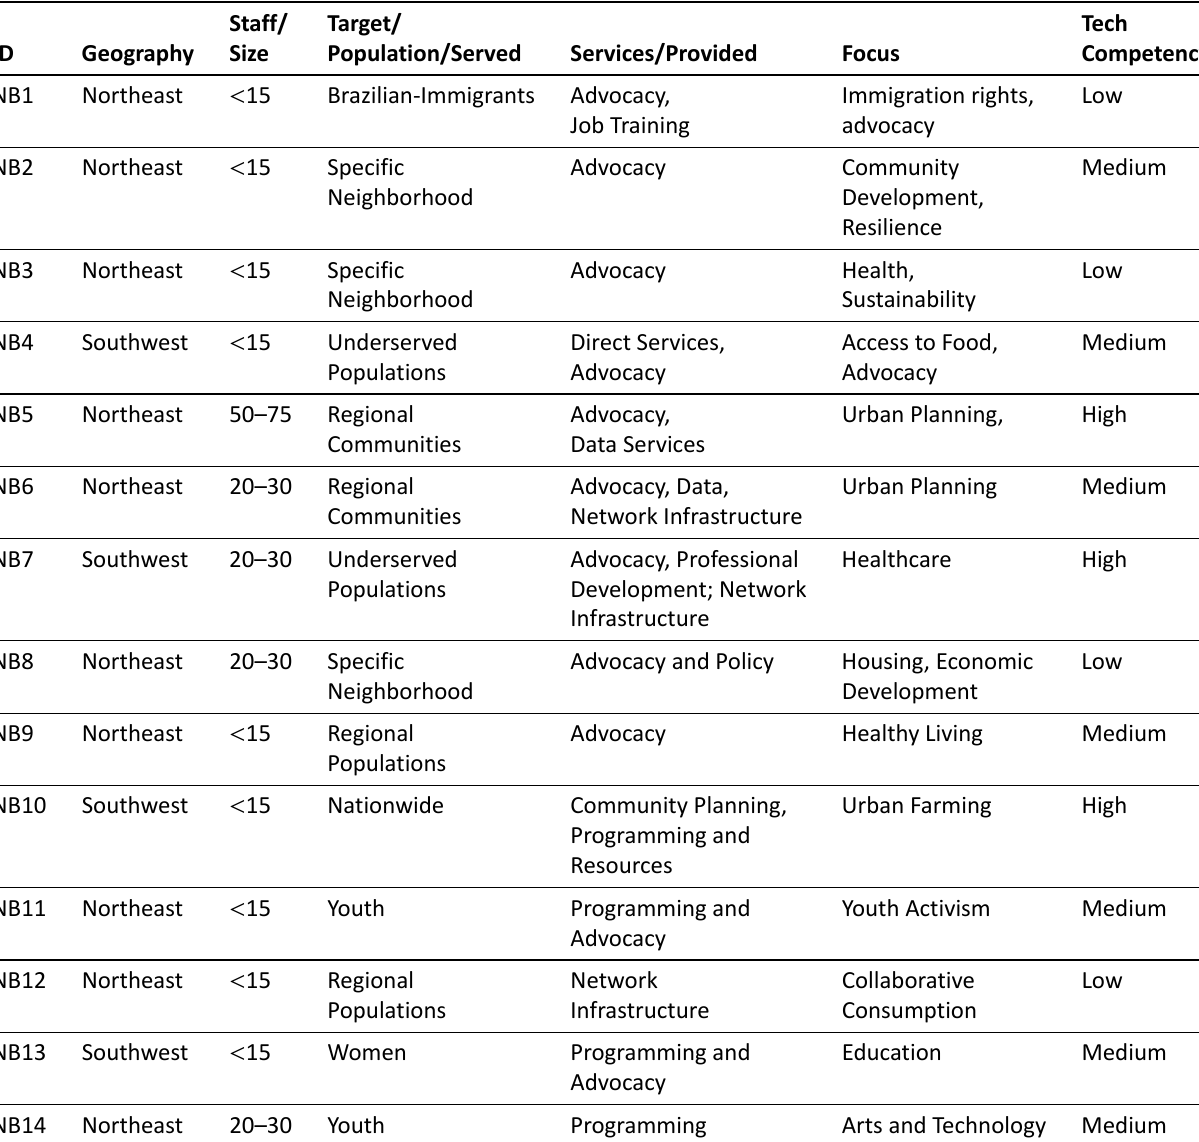
Table 1. List of organizations and their